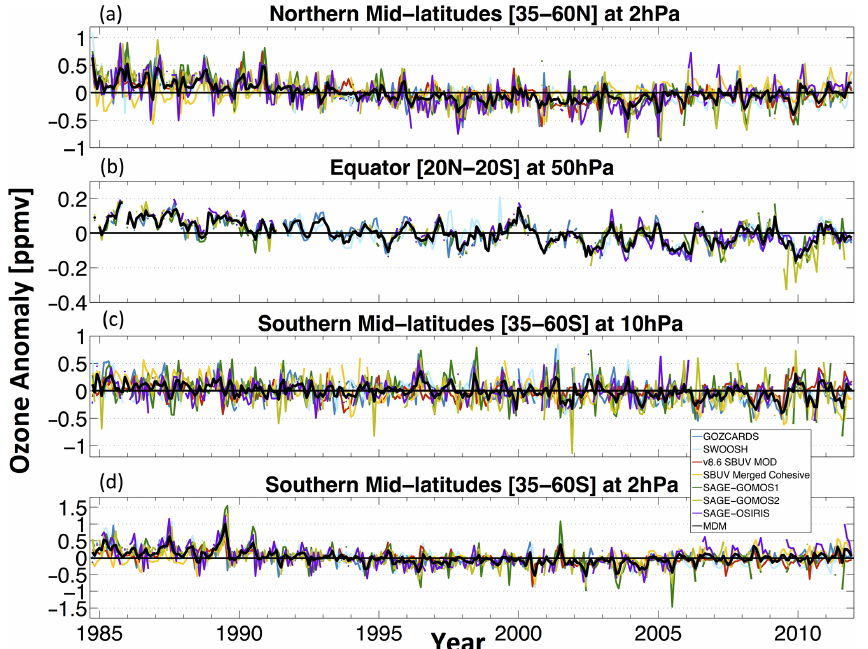
Figure 6. Monthly mean anomalies for (a) the Northern Hemisphere mid-latitudes (35–60 ◦ N) at 2hPa, (b) the tropics (20 ◦ N–20 ◦ S) at 50hPa, and (c) the Southern Hemisphere mid-latitudes (35–60 ◦ S) at 10hPa. Note the different y -axis ranges for each plot (a)–(d) .